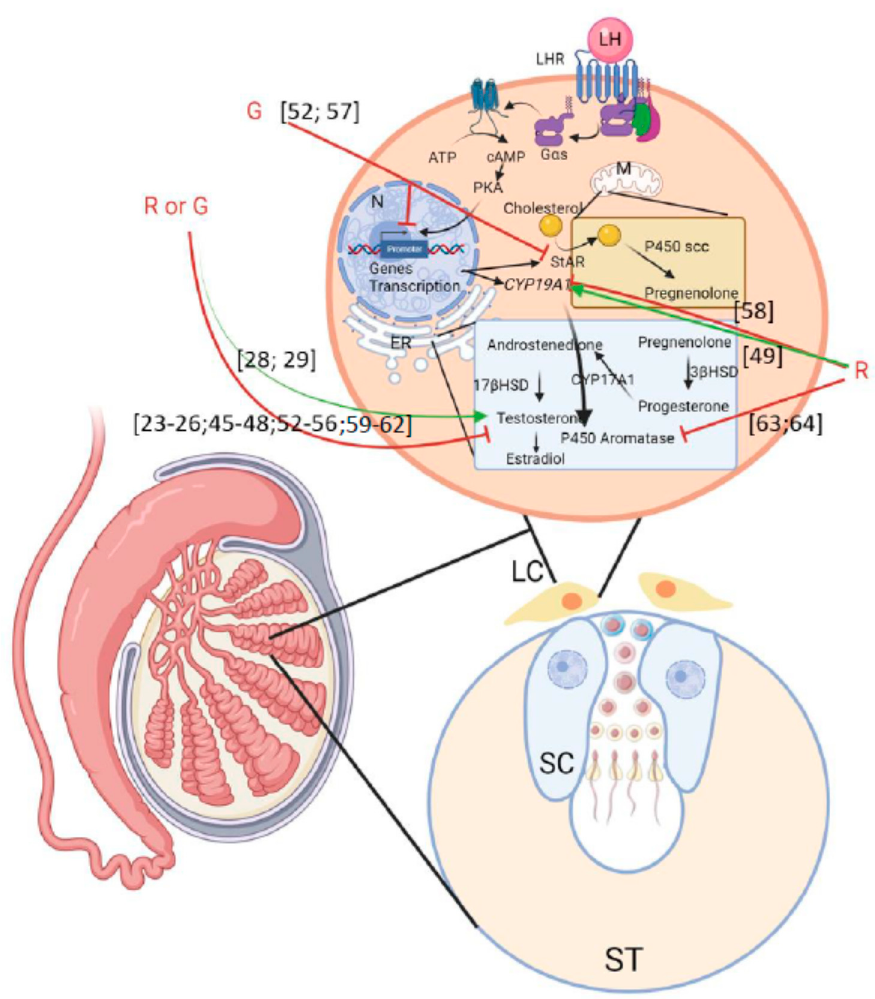
Figure 3. Scheme summering the effects of G or R on male fertility described in the literature. LC: Leydig cells; ST: seminiferous tube; SC: Sertoli cells. Green arrows mean activation and red arrows mean inhibition. Numbering in brackets indicates references. Table 4. Summary of in vivo studies of G or GBH exposure impact on testosterone secretion. * drinking water; Eq: equiv- alent. Numbering in brackets indicates references.